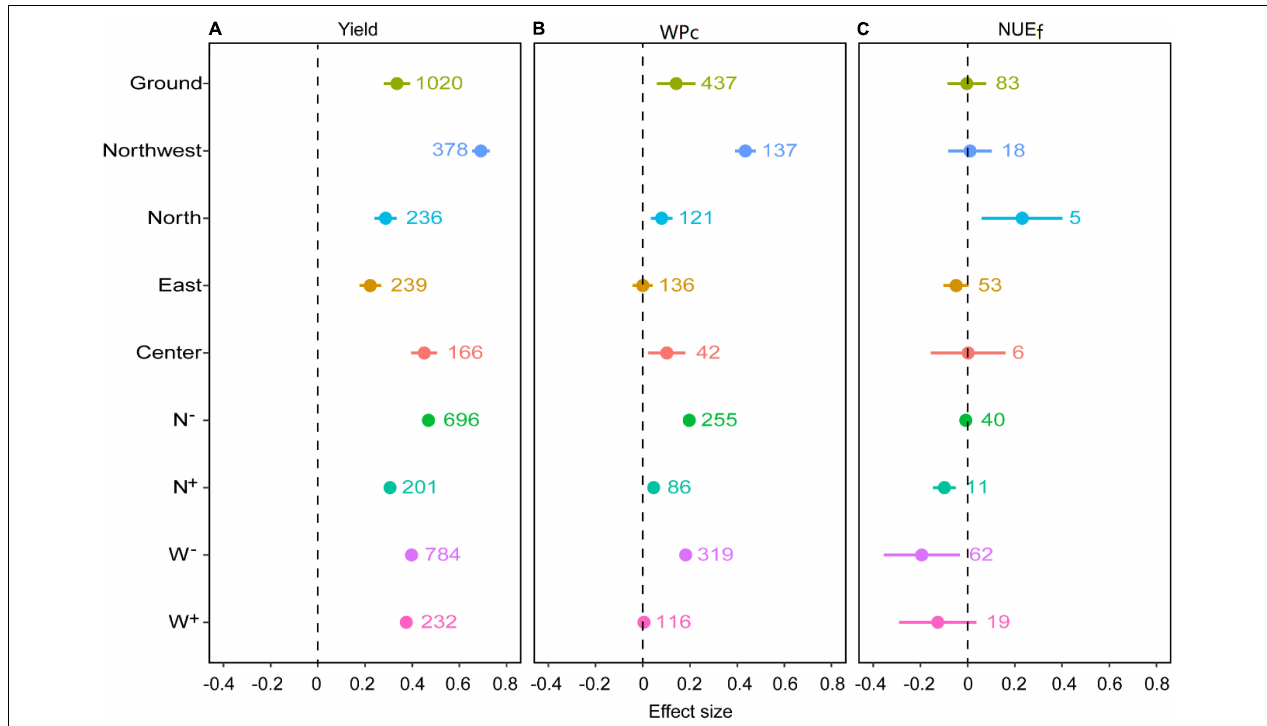
FIGURE 2 | The effect size of the total water and nitrogen inputs on (A) grain yield, (B) water productivity (WP c ), and (C) fertilizer nitrogen use efficiency (NUE f ) of wheat. Effect size indicates the weighted response ratio of the treatment relative to the control and CI indicates the 95% CIs. The sample size of each variable was displayed adjacent to each bar. Particularly, the total effect size (ground) was classified by regions (check the detail of classification in Figure 1 ), and levels of water and nitrogen input. The water levels that were above or below optimal water input were defined as above-optimal (N + ) and below-optimal N inputs (N - ); and above-optimal (W + ) and below-optimal water inputs (W - ). Subcategories were indicated by colors.